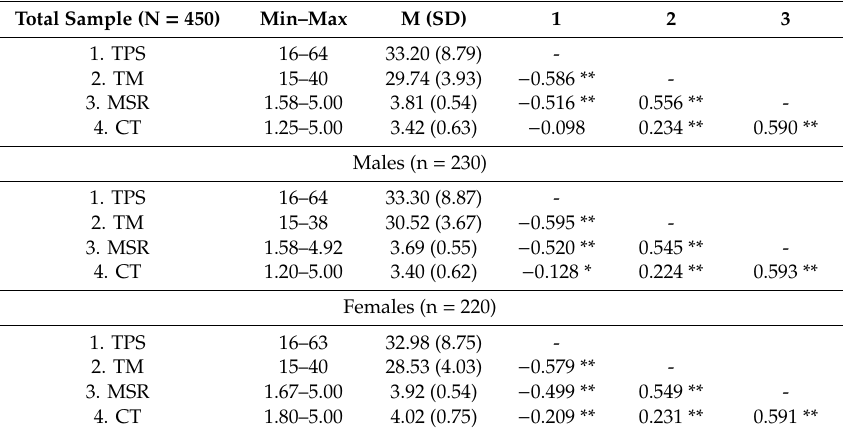
Table 1. Descriptive statistics and correlations (N = 450).